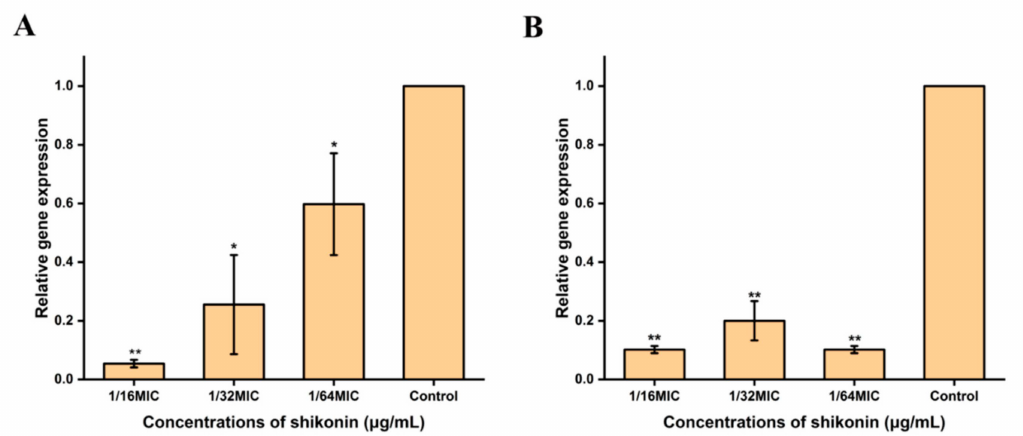
Figure 6. Shikonin inhibited the gene transcription of cidA and sarA . ( A ) The transcription of cidA of strain ATCC29213 treated with shikonin was detected by RT-qPCR; ( B ) The transcription of sarA of strain ATCC29213 treated with shikonin was detected by RT-qPCR. ** p < 0.01, * p < 0.05.